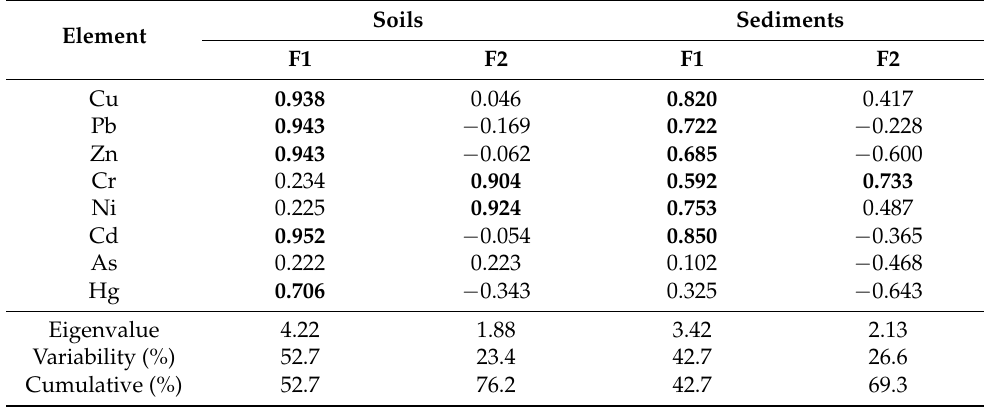
Table 3. Results of principal component